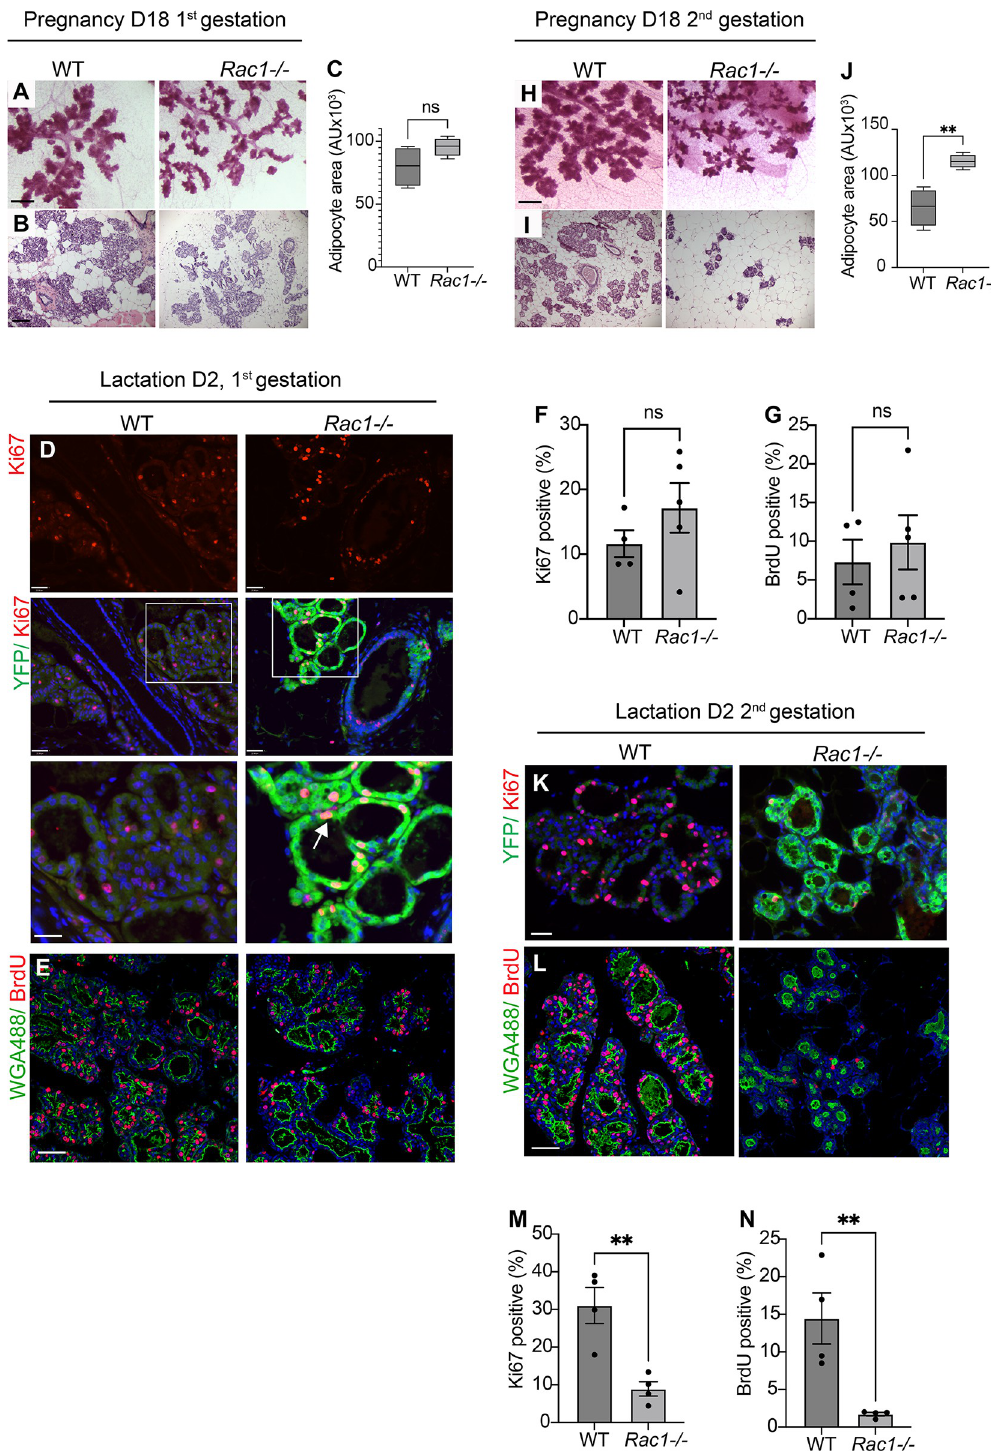
Fig 4. Distinct proliferation in Rac1−/− mammary glands within the first and second gestations. ( A , B ) Carmine staining of whole-mounted mammary glands ( A ) and HE stain ( B ) from WT and Rac1−/− mice at pregnancy day 18 in the first gestation. Bar: 2.8 mm ( A ) and 100 μ m ( B ). ( C ) Quantification of adipocyte areas from HE stains show no significant difference. Error bars: +/ − SEM of n = 4 mice per group. ( D ) Immunofluorescence staining with Ki67 in WT and Rac1−/− glands shows no difference in proliferation at lactation day 2 following the first gestation. Green fluorescent protein